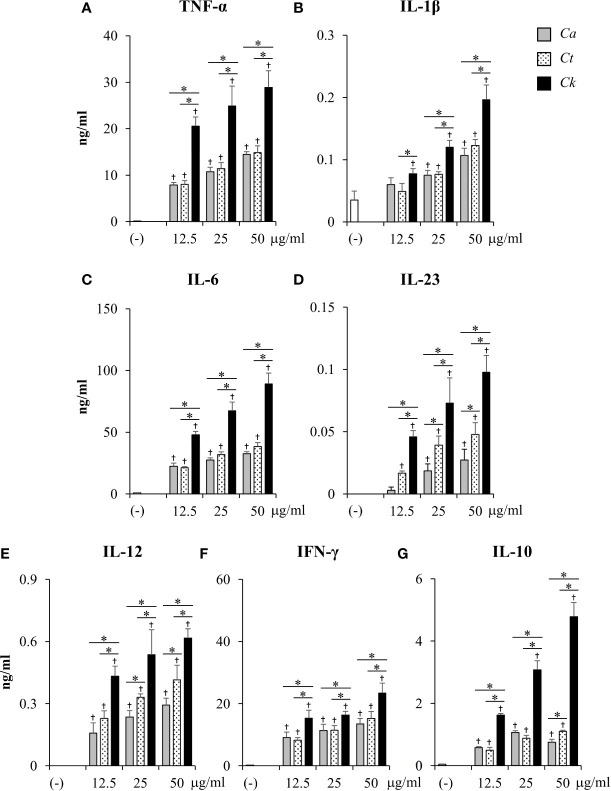
Excessive pro-inflammatory and anti-inflammatory cytokine production in C. krusei β-glucan-stimulated bone-marrow derived dendritic cells (BMDCs). BMDCs were stimulated with 12.5, 25, and 50 µg/ml of β-glucans isolated from C. albicans, C. tropicalis, and C. krusei for 24 h. Subsequently, the culture supernatants were collected and levels of (A) TNF-α, (B) IL-1β, (C) IL-6, (D) IL-23, (E) IL-12, (F) IFN-γ, and (G) IL-10 were quantitated by ELISA. n = 5; data are representative of two independent experiments. †
p < 0.05 compared with unstimulated BMDCs, *p < 0.05. (-), unstimulated BMDCs; Ca, C. albicans; Ct, C. tropicalis; Ck, C. krusei.